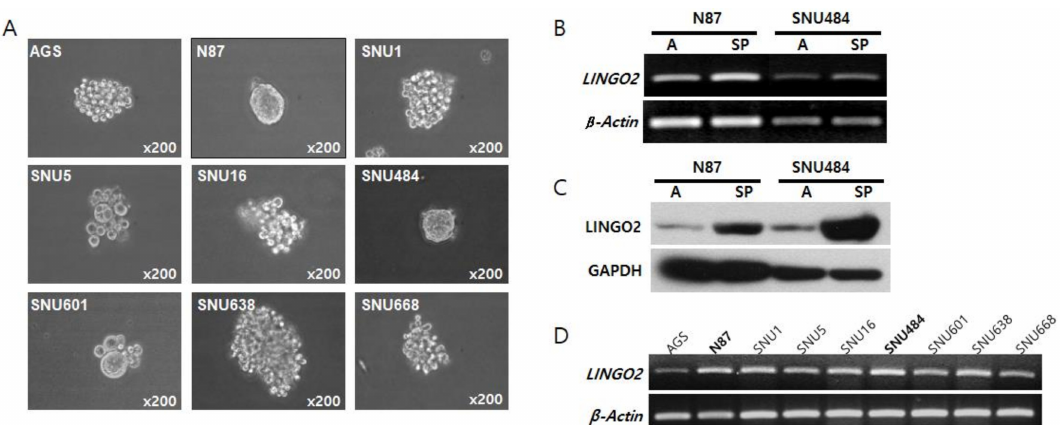
Figure 1. Expression of LINGO2 in gastric cancer cell-spheres ( A ) Gastric cancer cell lines including AGS, N87, SNU1, SNU5, SNU16, SNU484, SNU601, SNU638, and SNU668 were maintained with growth media and plated onto culture dishes or ultra-low attached plates in sphere media for sphere-formation assays and N87 and SNU 484 formed spheres. ( B ) LINGO2 mRNA expression and ( C ) protein expression was analyzed by RT-PCR and western blot, respectively, and LINGO2 mRNA as well as protein expression was elevated in gastric cancer sphere cells. (A, adherent cells; SP, sphere cells) ( D ) LINGO2 expression in all gastric cancer cell lines was analyzed by PCR